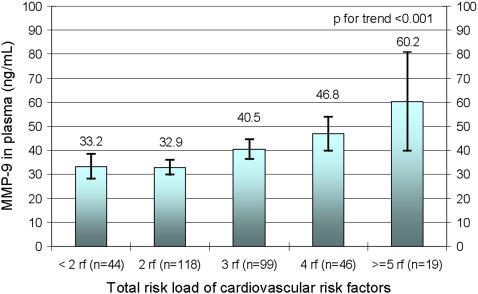
MMP-9 in relation to total risk load.Dichotomies of eight risk factors are taken into account in the analysis: n = 326 with full information on every variable. Blood pressure (SBP>160 and/or DBP>100 mm Hg and/or using antihypertensive agents, n = 81), LDL/HDL (ratio >3, n = 54), obesity (BMI>30, n = 67), diabetes (yes, n = 22), smoking (yes, n = 57), alcohol intake (>170 grams/week, n = 37), low physical activity (all other than top ordinal category, n = 272), low fruit and vegetables intake (all other than top ordinal category n = 307). Mean and 95% confidence intervals.